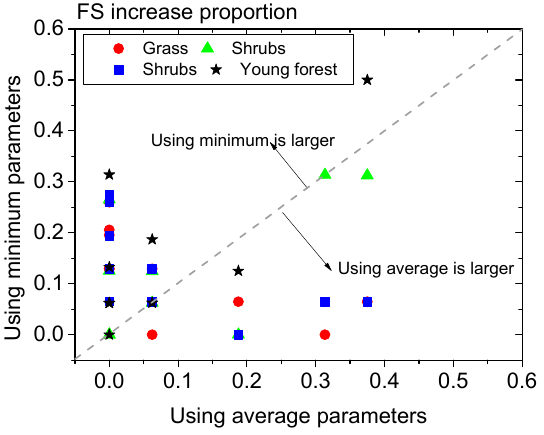
Figure 14. Comparison of the FS increase proportion using average and minimum soil strength parameters.